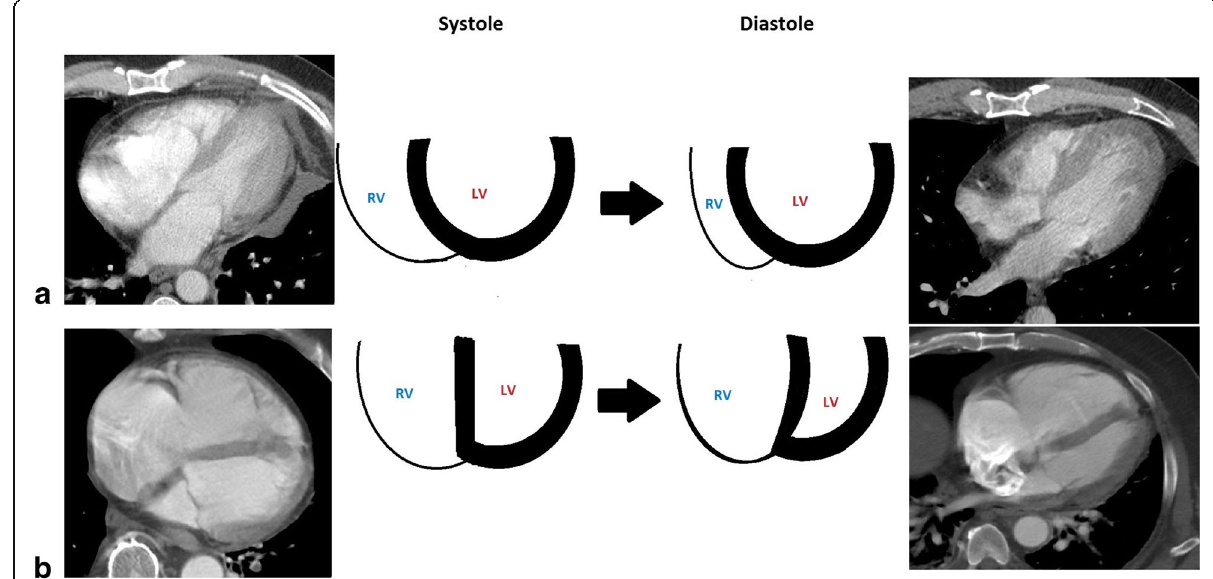
Fig. 4 Normal and abnormal appearance of right and left ventricles due to afterload. a Depicts normal systolic and diastolic appearance of the right and left ventricles. b Demonstrates a dilated right ventricle that impinges on the left ventricle due to increased afterload